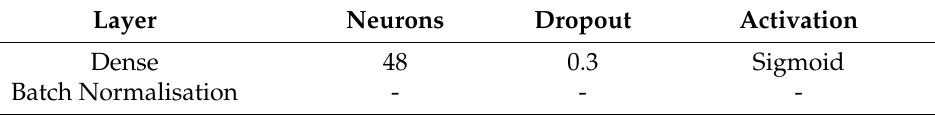
Table A5. The layer details of Block 3.0.